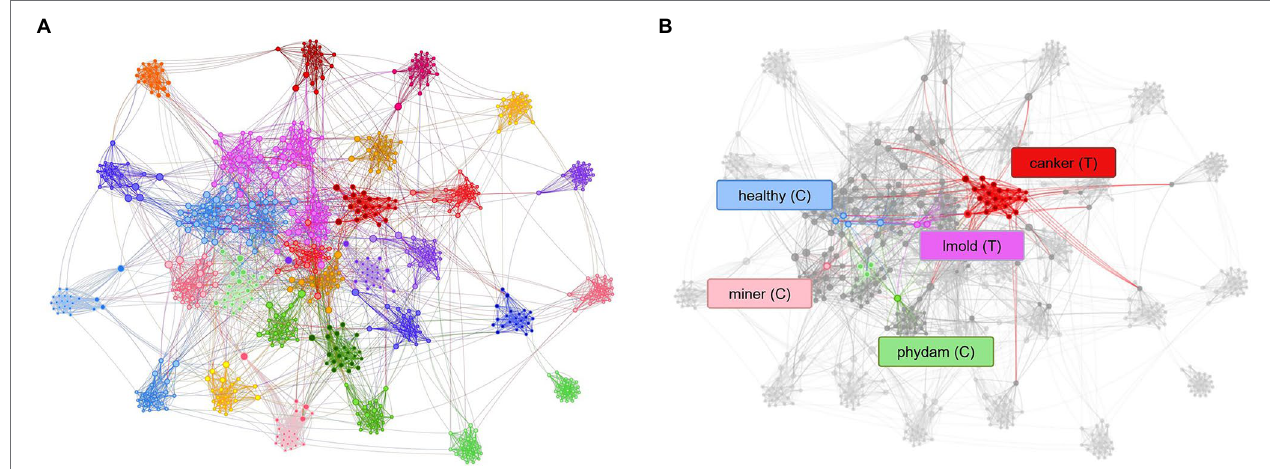
FIGURE 9 | Representation of the tSNE distribution obtained from the model trained using control classes. (A) t-SNE distribution and class association. (B) Control classes provide sufficient information to assign samples to their respective category. Each dot represents a sample, and the colors identify the class assignation. Lines between dots show the connection of each sample to the center of its corresponding class. Class notations are introduced in Section “Criteria for Data